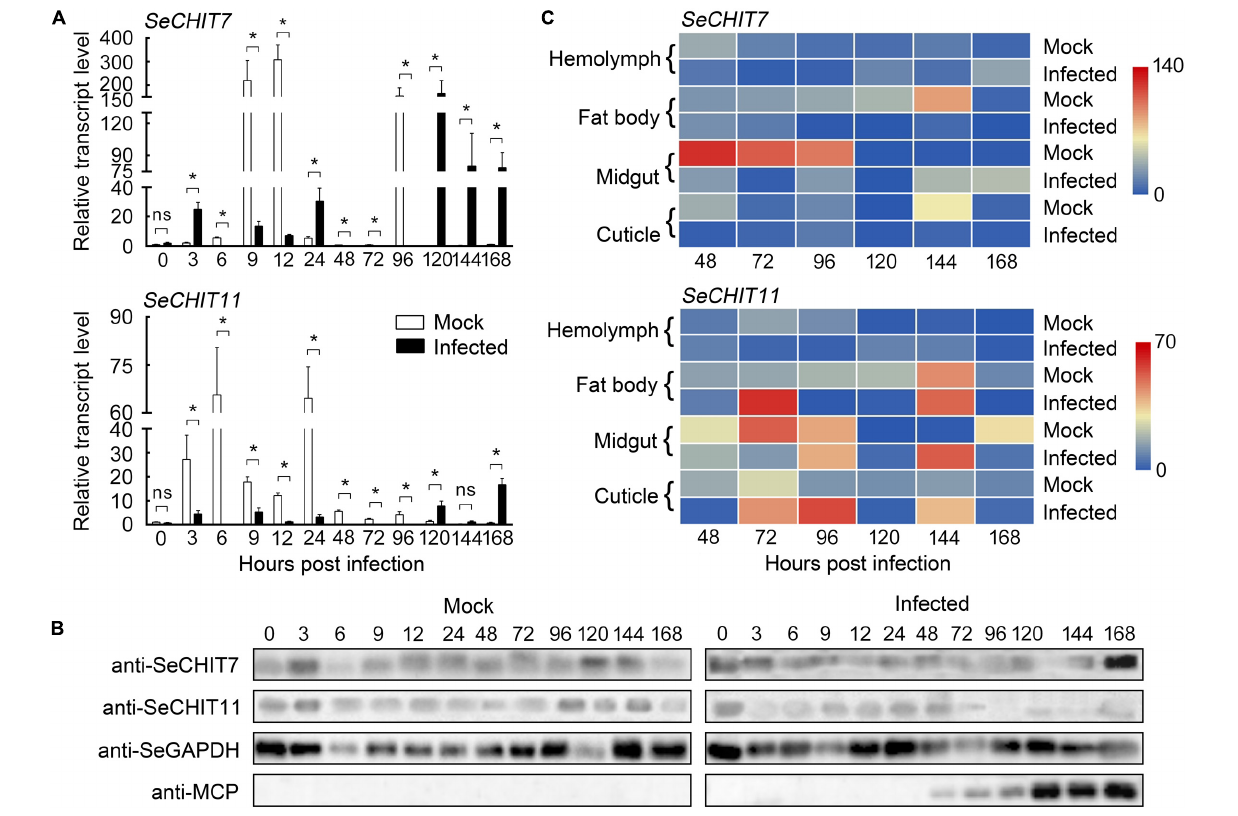
FIGURE 2 | The effect of HvAV-3h on transcription and expression in Spodopera exigua larvae. (A) Relative transcriptional level of the SeCHIT s in larval whole bodies after HvAV-3h infection. (B) Expression of the SeCHITs in larval whole bodies. (C) Heat map of relative transcriptional level of the SeCHIT s in different tissues after HvAV-3h infection. Mock, mock-infected larvae; Infected, infected larvae. * indicates significant difference between mock-infected and infected ( p < 0.05), ns indicates no difference in transcription level according to t